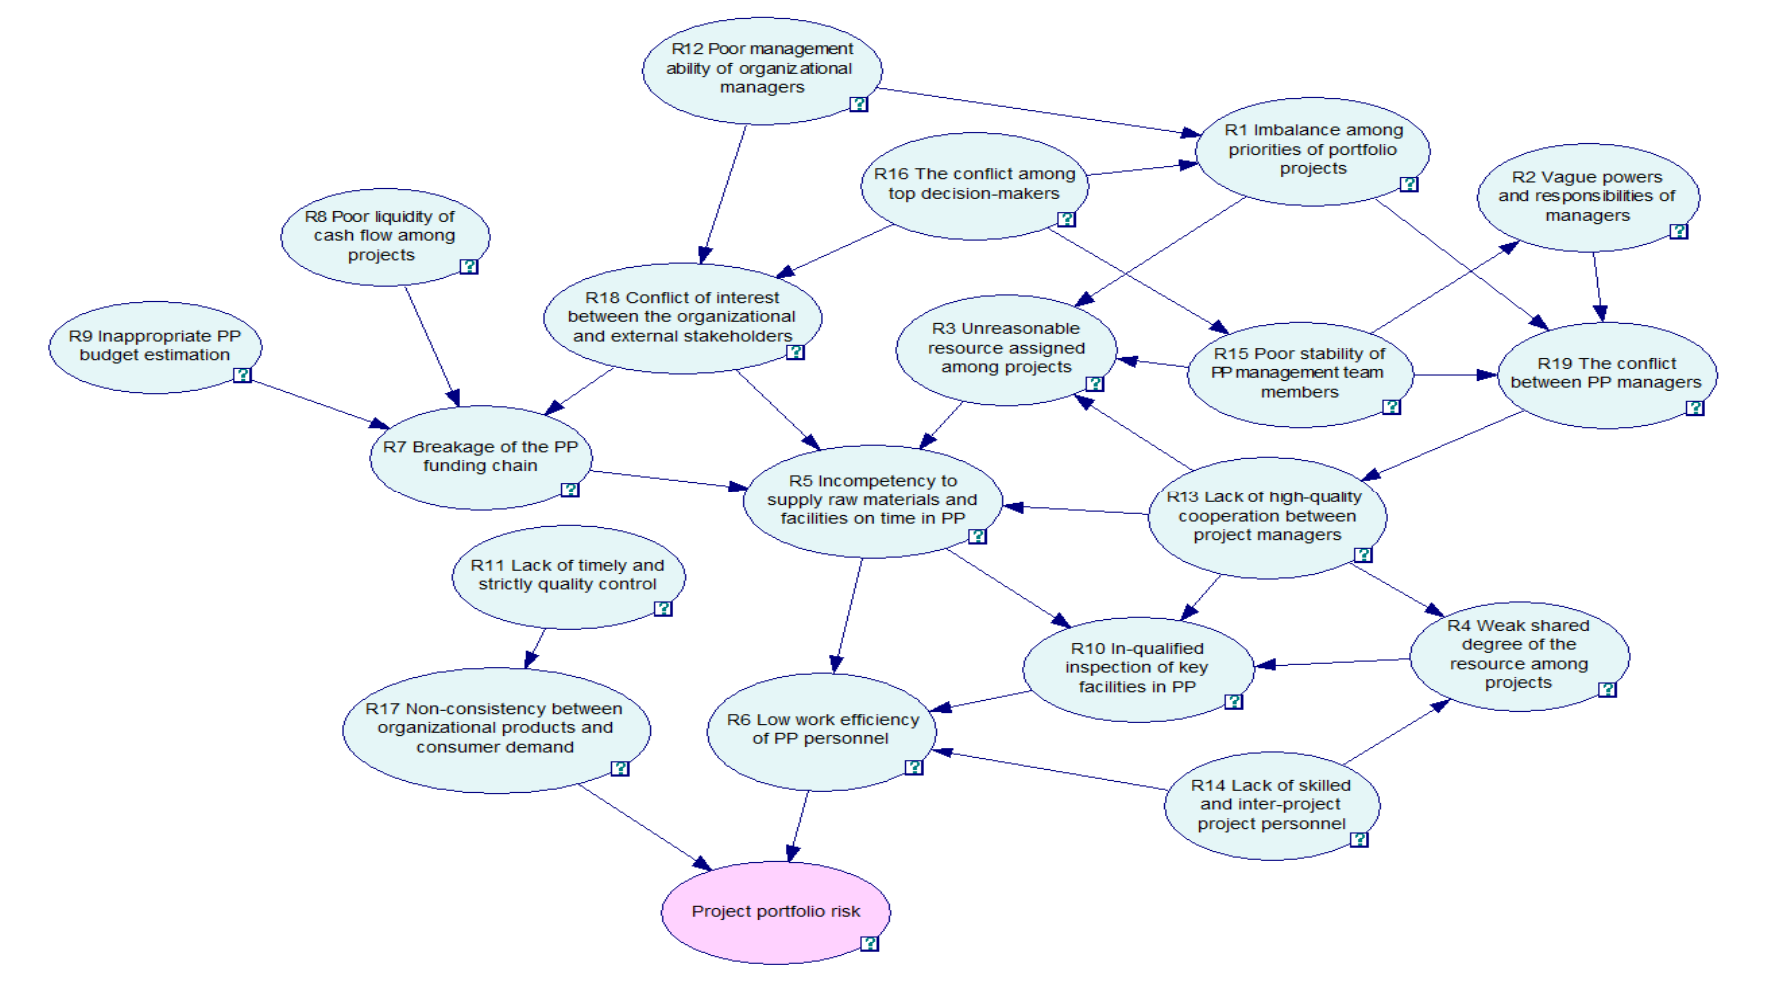
Figure 2. The initial network of the DBN.